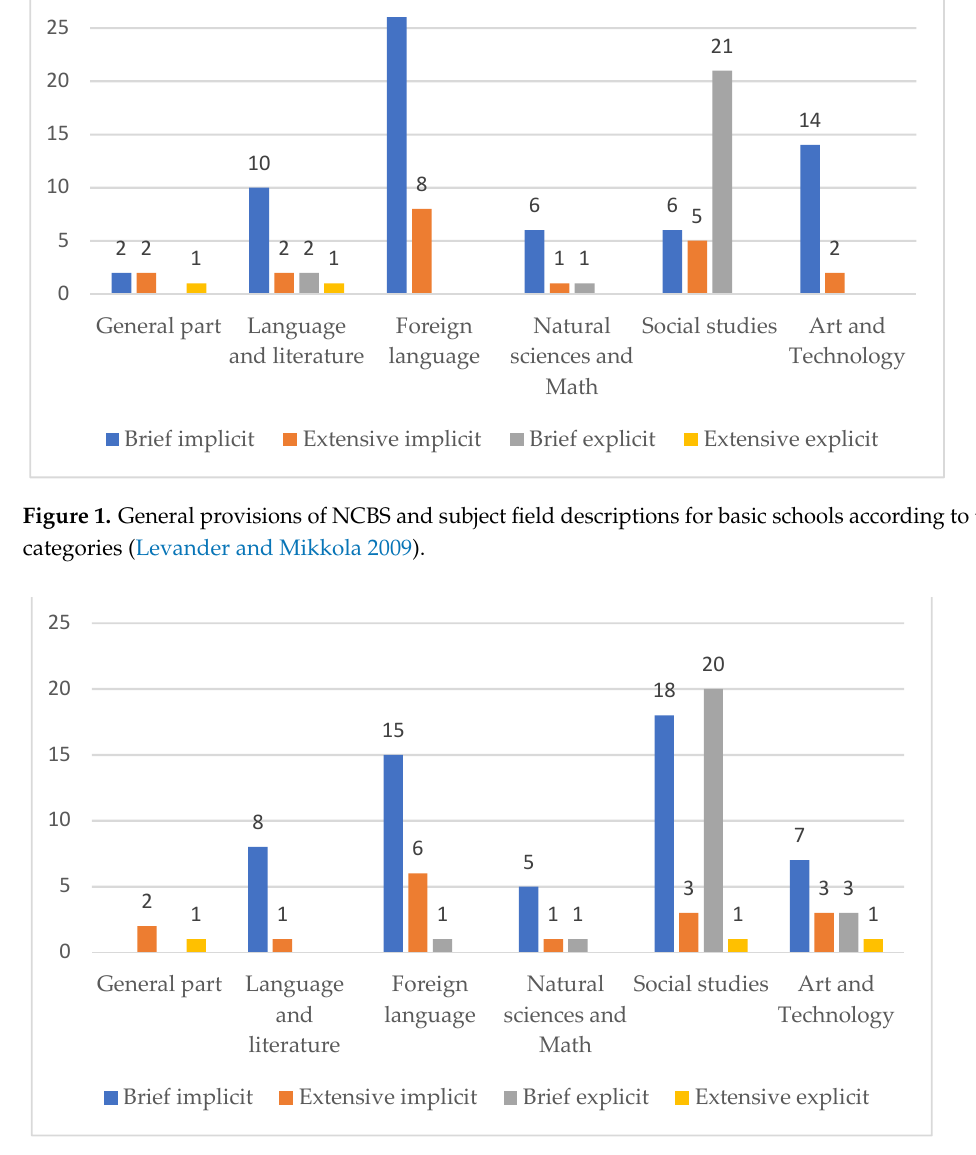
Figure 2. General provisions of NCUSS and subject field descriptions for upper secondary schools according to the categories (Levander and Mikkola 2009).